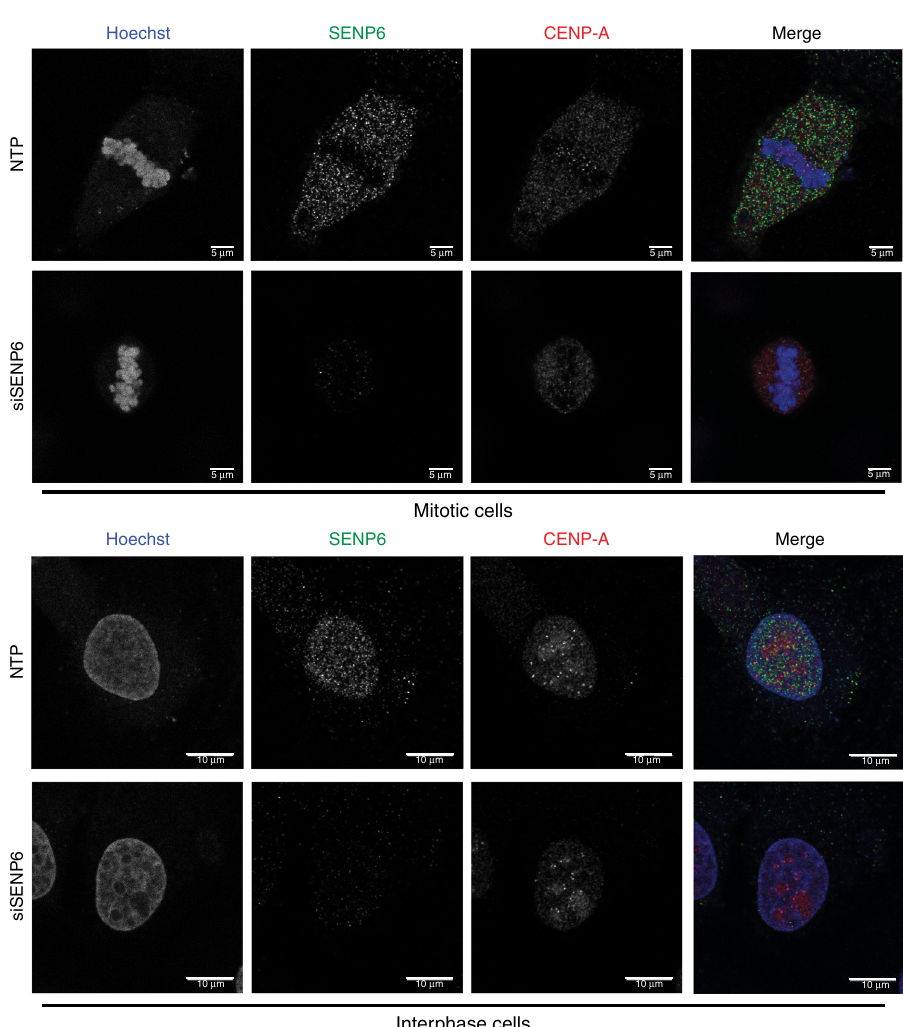
Fig. 8 SENP6 localizes to the nucleoplasm. U2OS cells were grown on coverslips overnight, transfected either with a pool of four siRNAs against SENP6 (siSENP6) or a pool of four nontargeting siRNAs (NTP). Cells were fi xed 2 days post transfection and co-stained with Hoechst to visualize DNA and antibodies directed against SENP6 and CENP-A. Panels show representative pictures of mitotic (upper panel) and interphase cells (lower panel). Scale bar = 5 µ m (mitotic cells), 10 µ m (interphase cells). Source data are provided as a Source Data fi